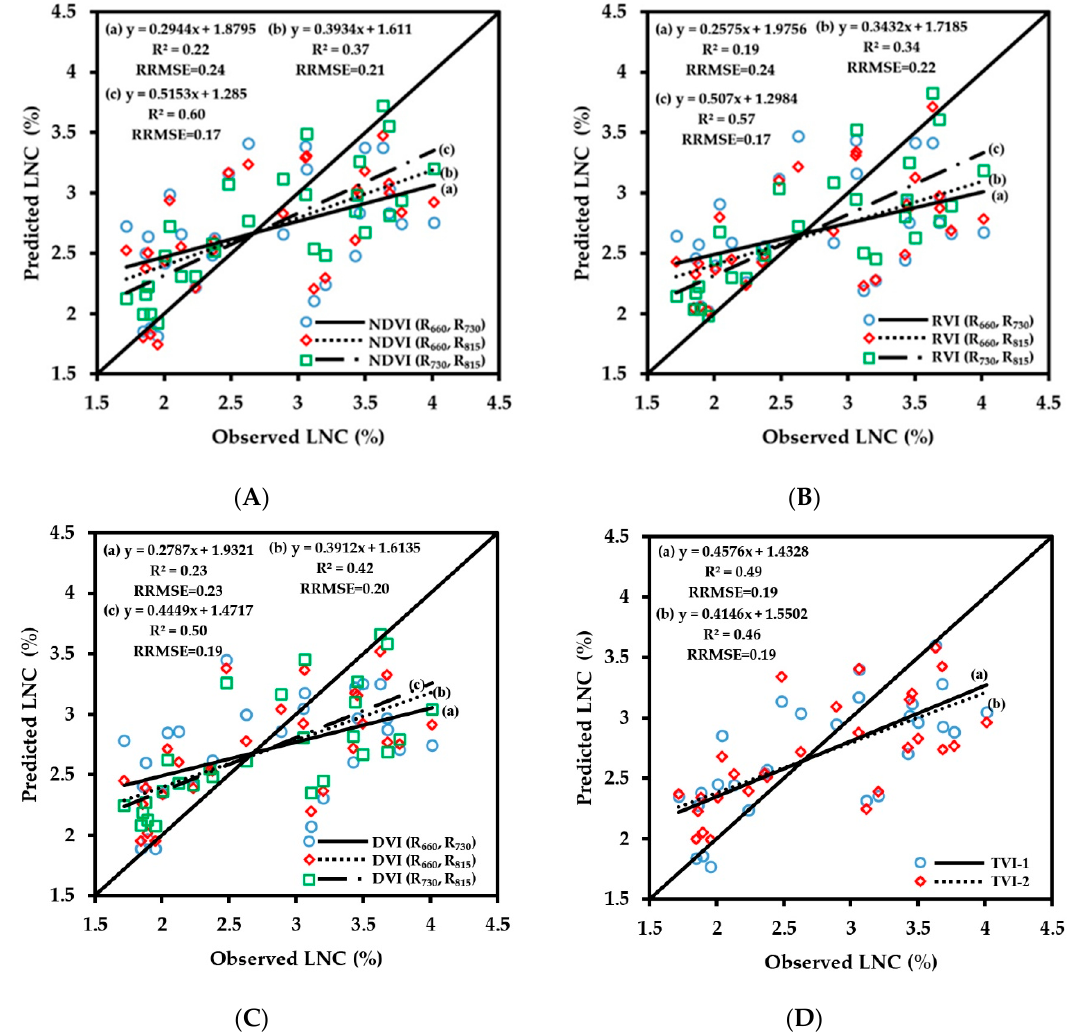
Figure 11. The relationships between observed and predicted LNC values of wheat varieties based on NDVI ( A ), RVI ( B ), DVI ( C ) and TVI ( D ) models.